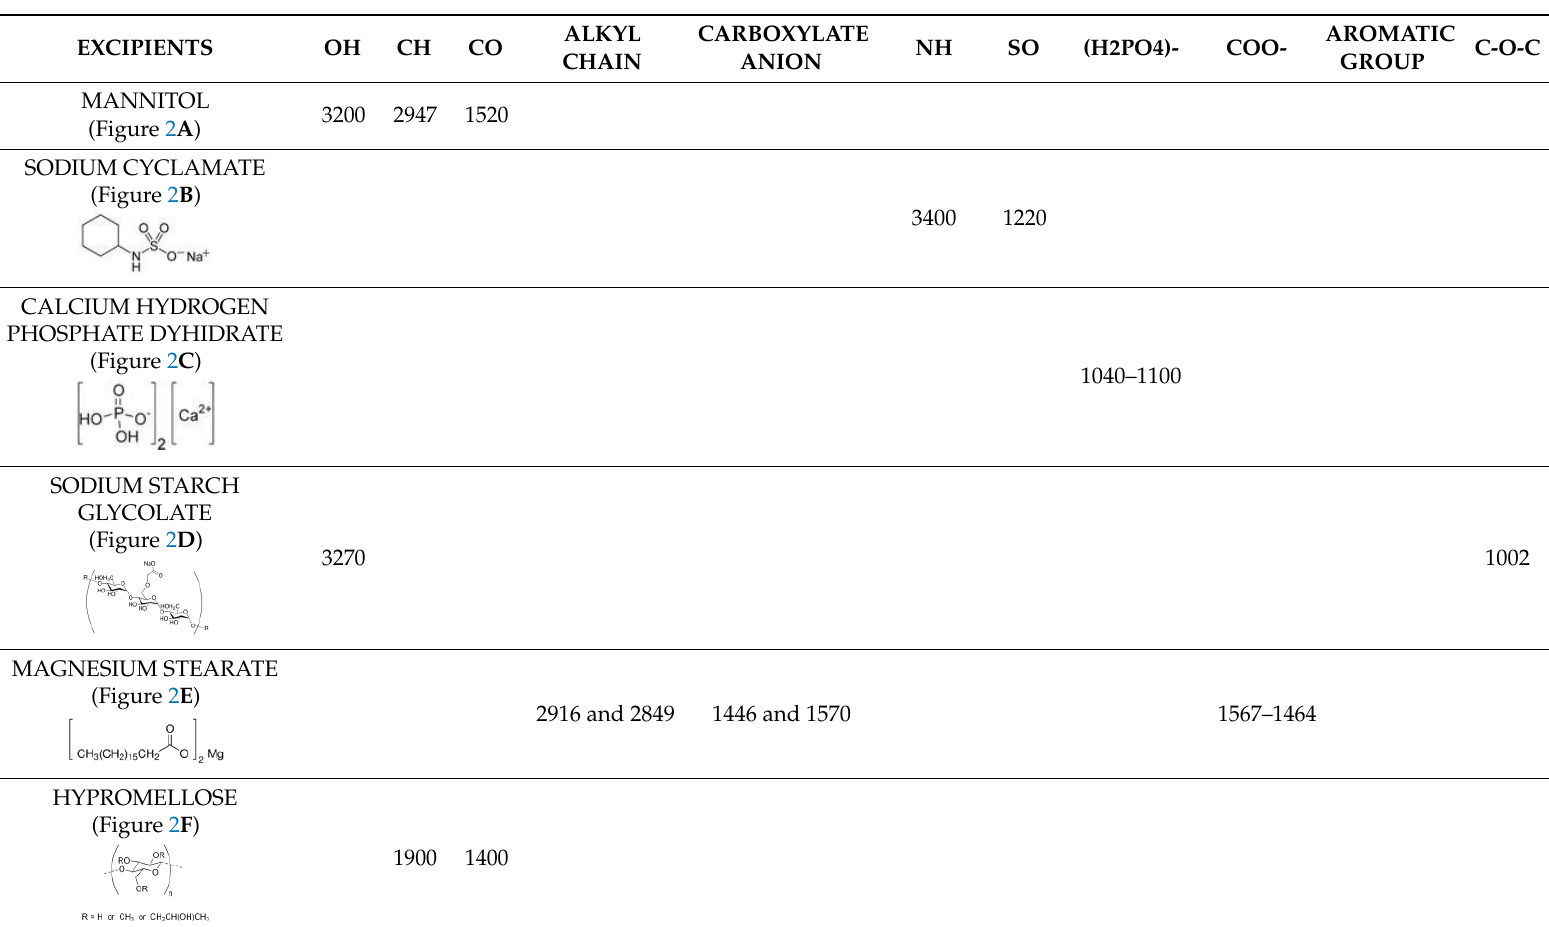
Table 2. Characteristic absorption peaks of the excipients used in cm − 1 .